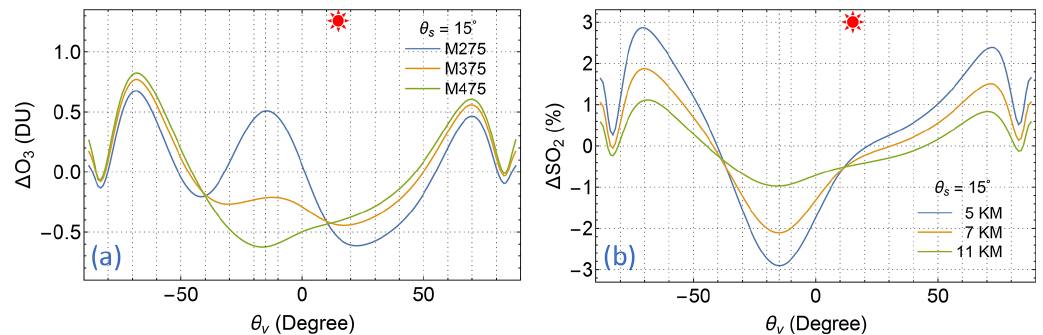
Figure 20. Errors in retrieved O 3 and SO 2 due to Lambertian surface treatment of an anisotropic surface. (a) O 3 errors in DU for a midlatitude O 3 profile with total columns of 275, 375, and 475DU. (b) SO 2 errors in percent for an SO 2 layer at altitudes of 5, 7, and 11km above sea level. See the Fig. 4 caption for the specification of surface BRDF and viewing and illumination geometry.